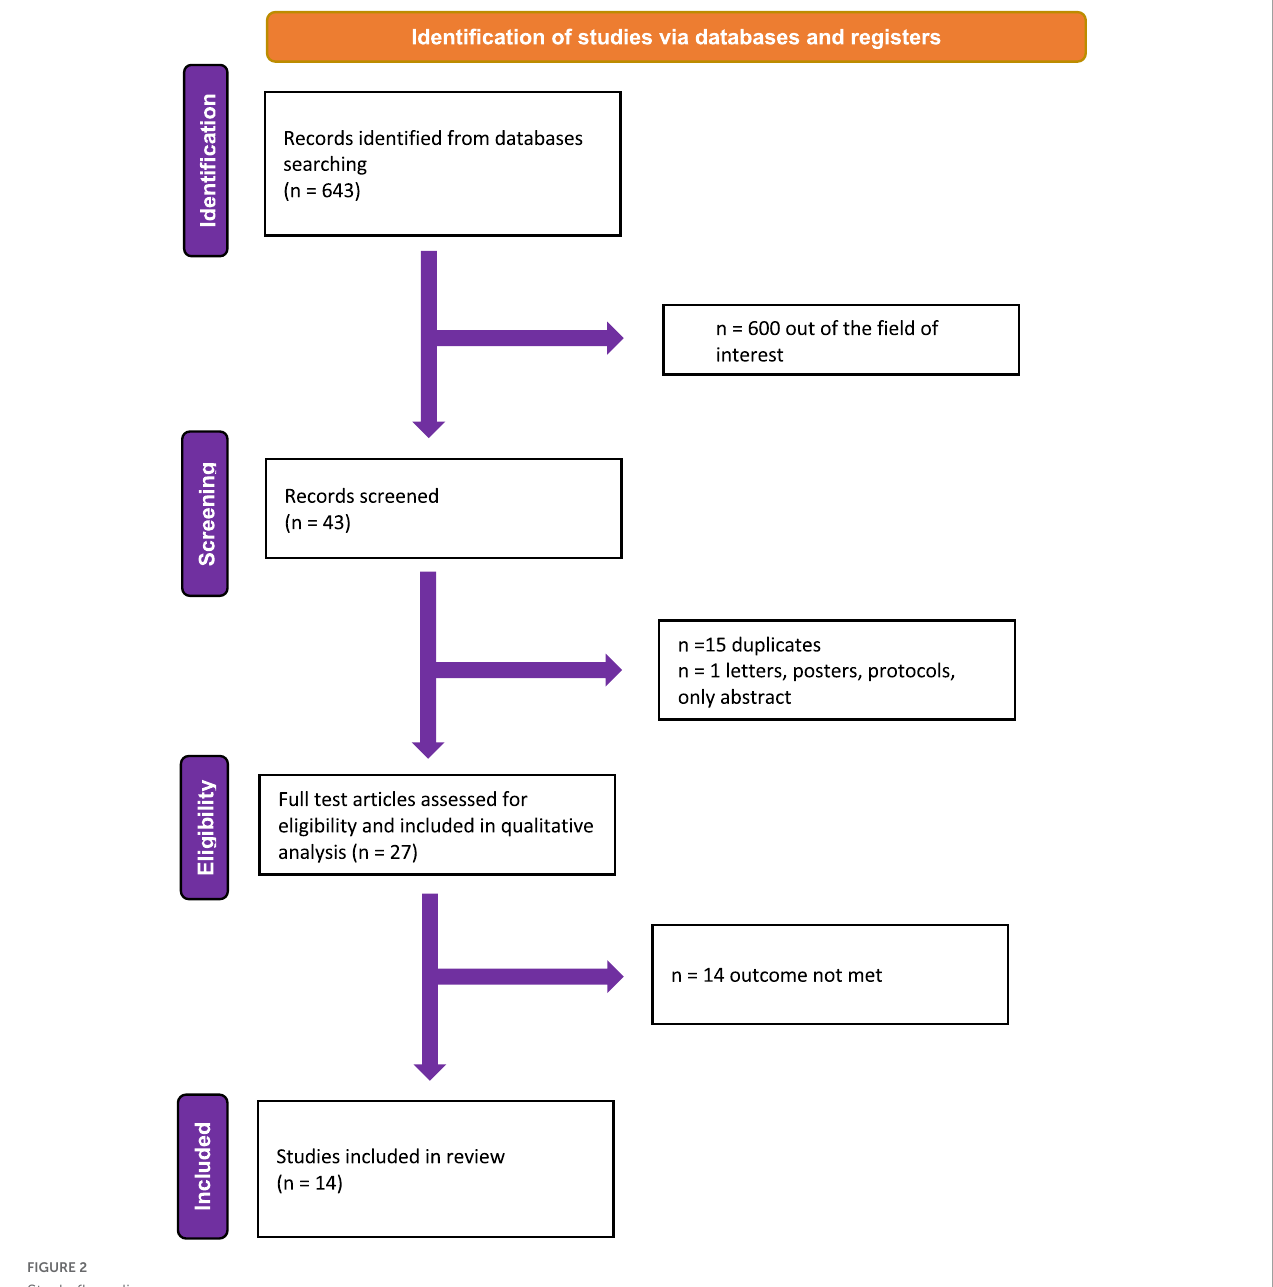
FIGURE2 Study flow